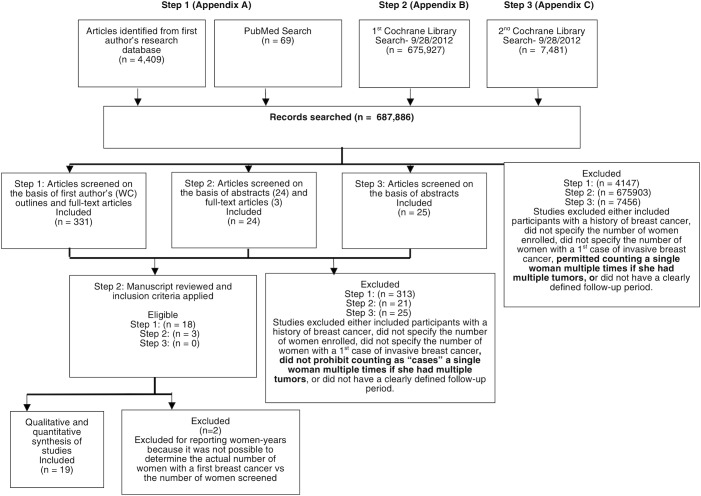
The Flowchart of Search Steps for Retrieval of 19 Qualified Studies.